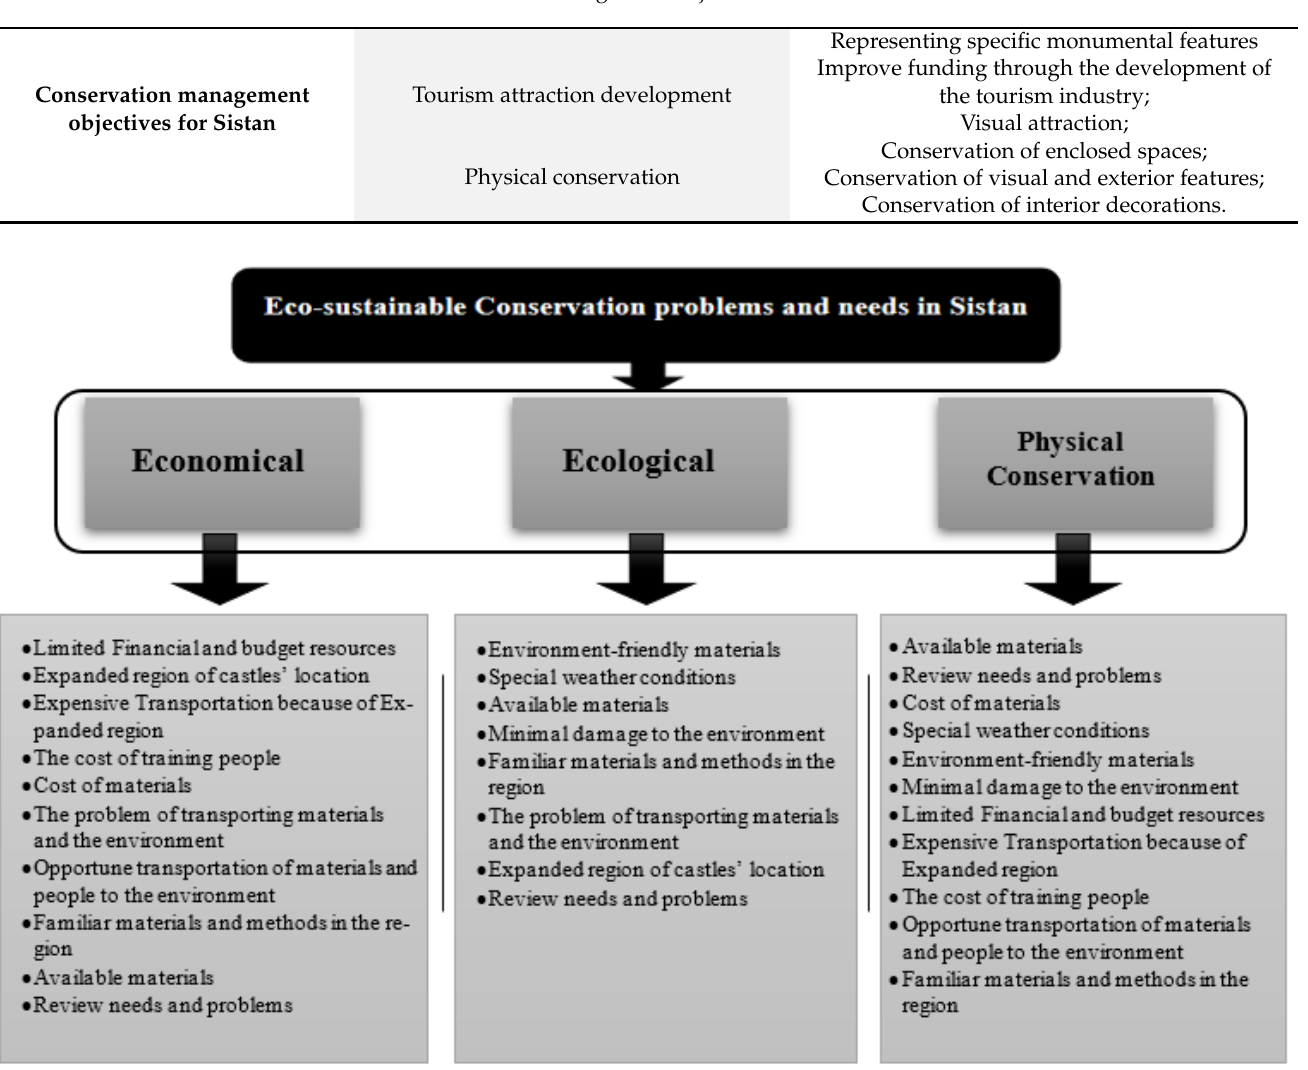
Table 2. Conservation management objectives for Sistan Castles.